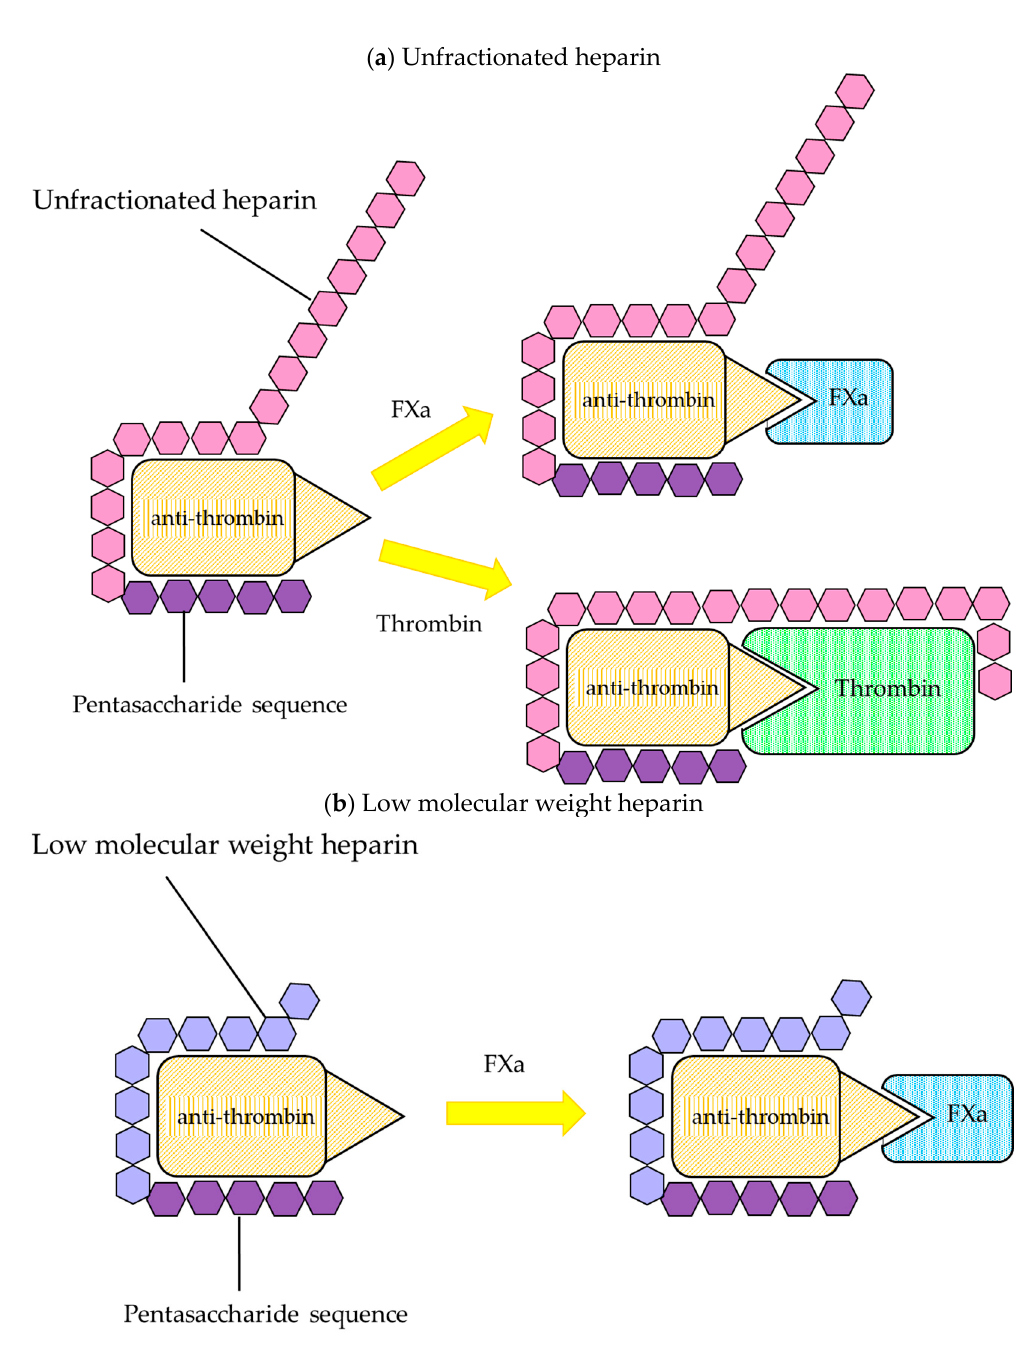
Figure 1. Inactivation of coagulation factors by heparin. Heparin binds to antithrombin (AT) through a high affinity pentasaccharide sequence. AT conformational structure is changed by binding to heparin, and it accelerates the interaction with thrombin or factor Xa. ( a ) Unfractionated heparin (UFH) can inactivate both thrombin and factor Xa. High molecular weight heparin is required to bind to thrombin. ( b ) Low molecular weight heparin (LMWH) catalyzes the inactivation of factor Xa by antithrombin. At least 18 saccharide units are required to catalyze the inactivation. LMWH has less inhibitory activity against thrombin than UFH.